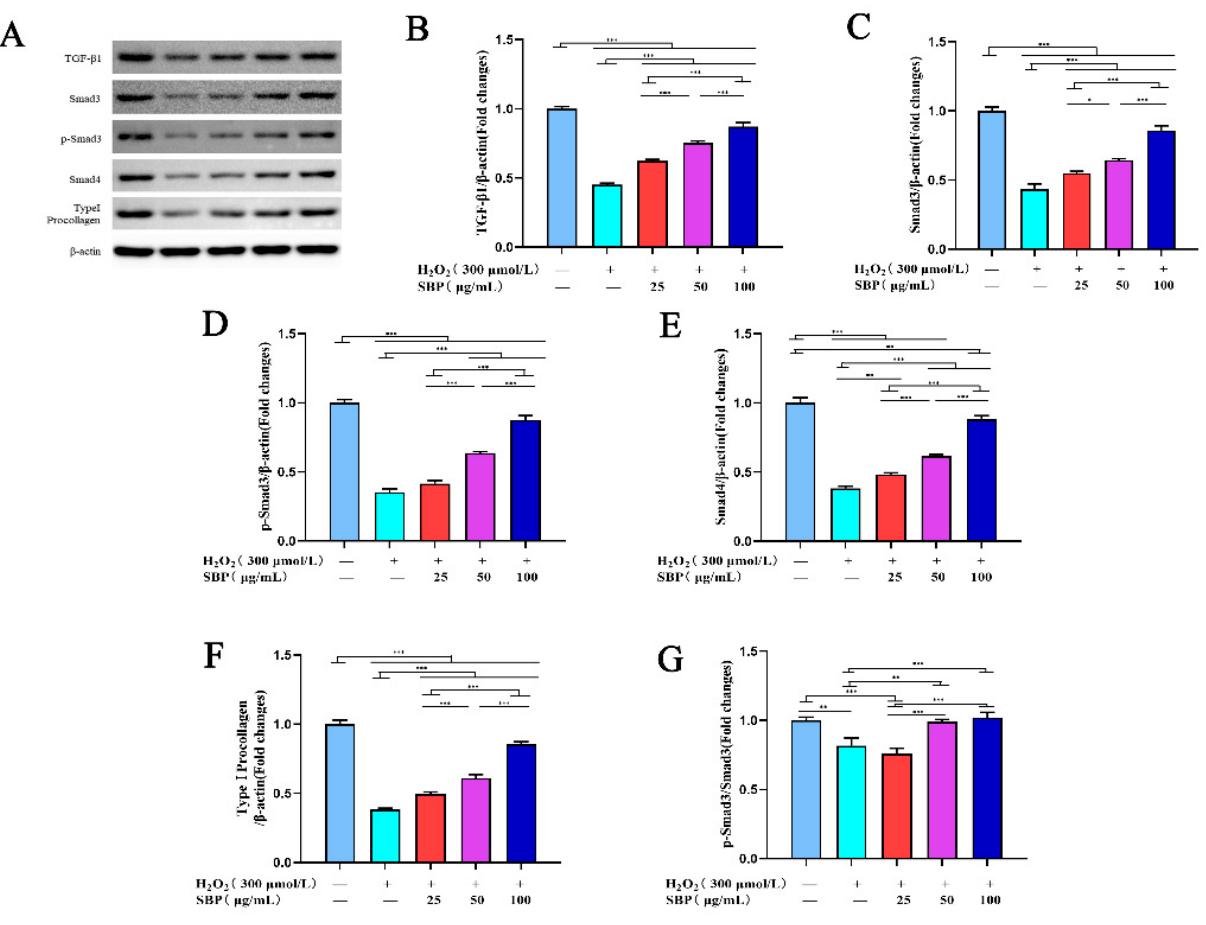
Figure 5. Effect of SBP on the synthesis of Type I procollagen by the TGF- β 1/Smads pathway. ( A ): Protein bands of related proteins in the TGF- β 1/Smads pathway. ( B – F ) TGF- β 1, Smad3, p-Smad3,